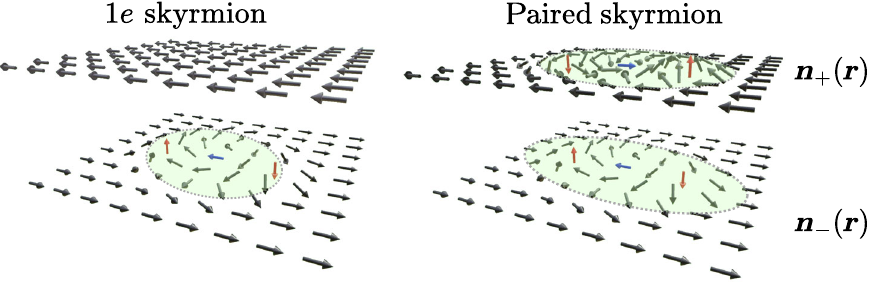
FIG. 1. Caricature of 1 e skyrmions and paired 2 e skyrmions at ν ¼ 0 . Arrows depict the local orientation of pseudospins n two Chern sectors ( C ¼ (cid:2) 1 ) as defined in Eq. (2) for skyrmions about the KIVC insulator at charge neutrality. Green shaded regions show where the doped electric charge is localized. Blue arrows indicate the center of the skyrmions, and red arrows denote where pseudospins are aligned along the z